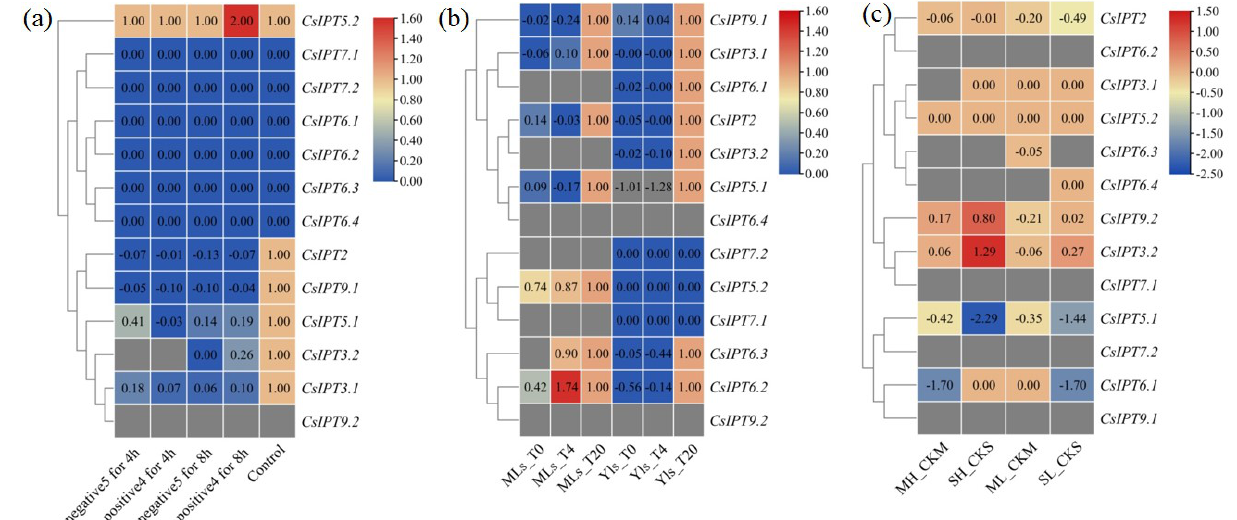
Figure 8. Expression profiles of CsIPT genes in tea plants in response to temperature stresses. Transcriptional levels of CsIPT genes under chilling and freezing stresses ( a ). Transcriptional levels of CsIPT genes under cold stresses ( b ). Transcriptional levels of CsIPT genes under high- and low-temperature stresses ( c ).